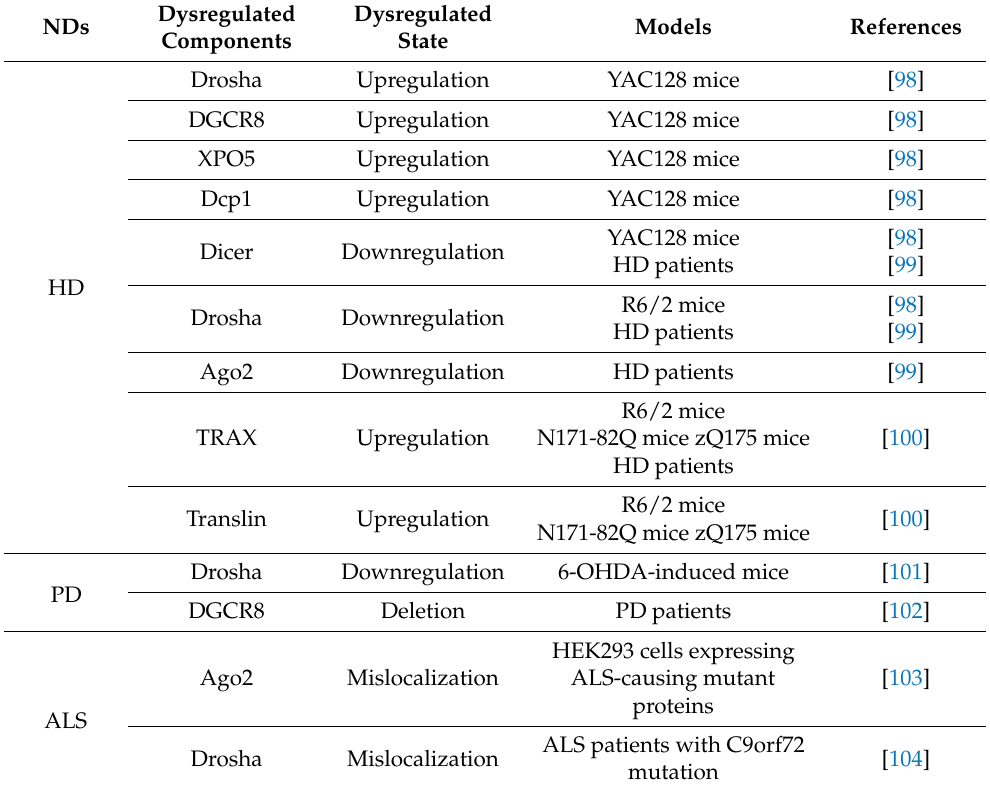
Table 2. List of dysregulated microRNA (miRNA) biogenesis machinery in neurodegenerative diseases